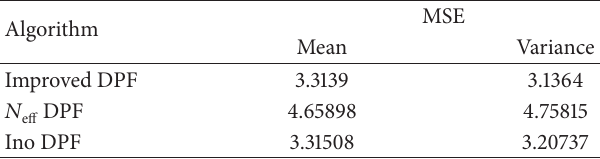
Table 3: The comparison of mean and variance in Experiment